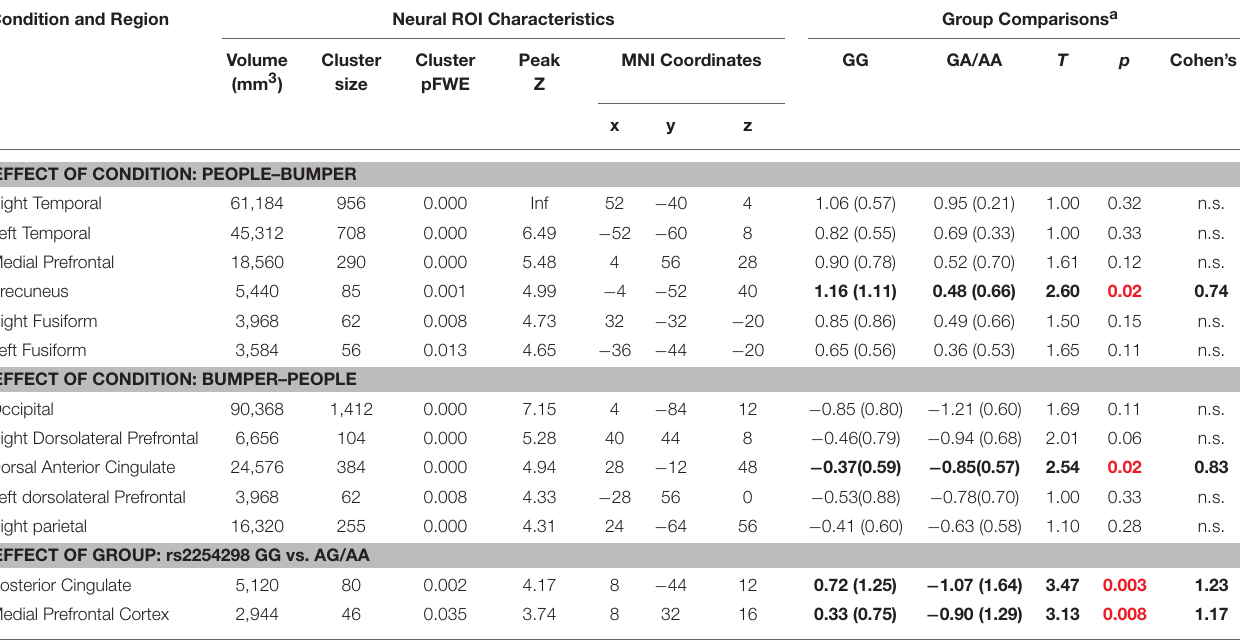
TABLE 2 | Whole-brain two-sample t -test regions related to fMRI task effects and genotype for rs2254298. Condition and Region Neural ROI